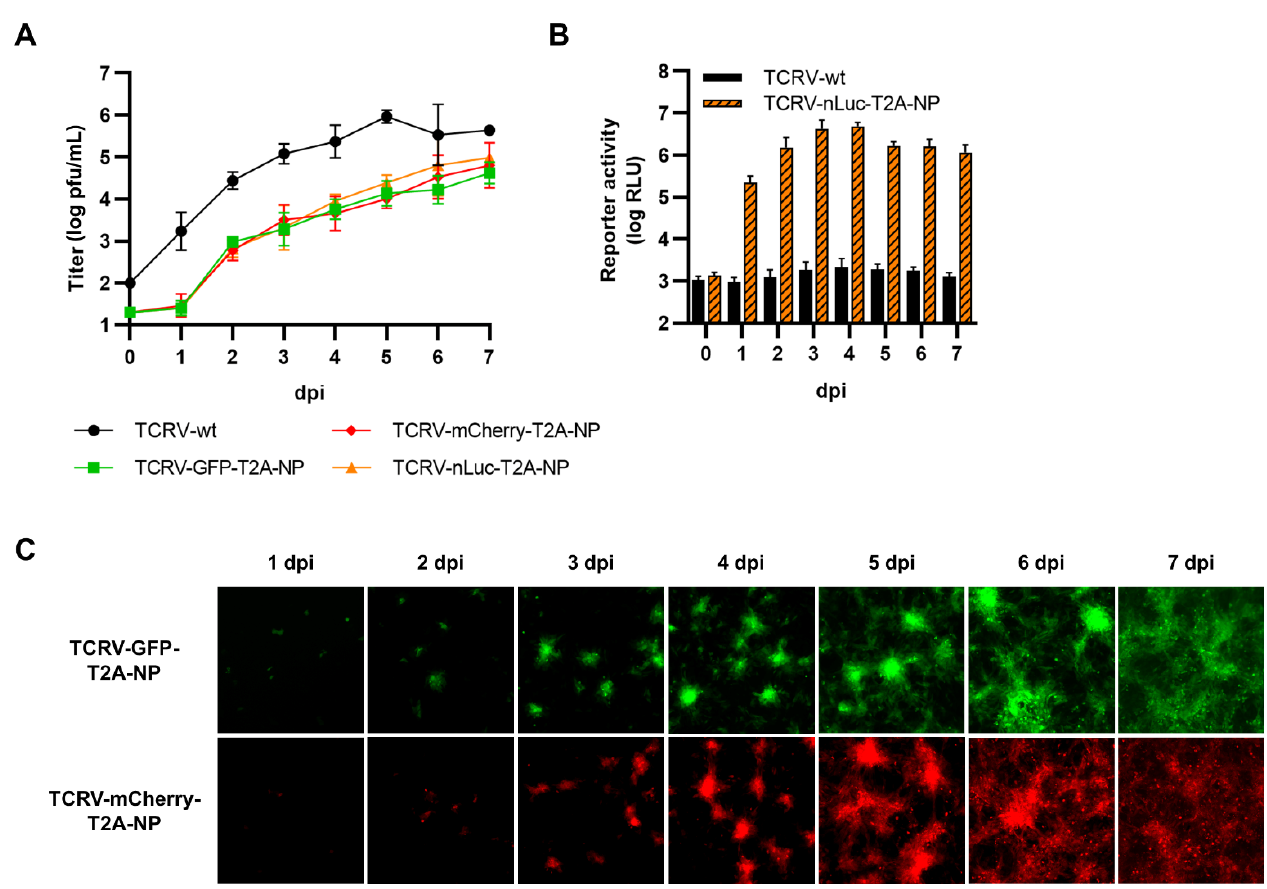
Figure 3. Recombinant viruses encoding N-terminal fusions of TCRV NP to reporter proteins. ( A ) Growth kinetics. Vero76 cells were infected at MOI = 0.005 with the indicated viruses. Supernatants were harvested on the indicated days and titrated by plaque assay in Vero76 cells. Results are shown as mean ± SD of three independent experiments. ( B ) Reporter activity (nLuc). Cells infected as in ( A ) were lysed on the indicated days, and nLuc activity in lysates was measured. Results are shown as mean ± SD of three independent experiments. ( C ) Reporter activity (GFP/mCherry). Pictures of cells infected as in ( A ) were taken on the indicated days at 10× magnification. Results are shown as representative images from one experiment out of three independent experiments.